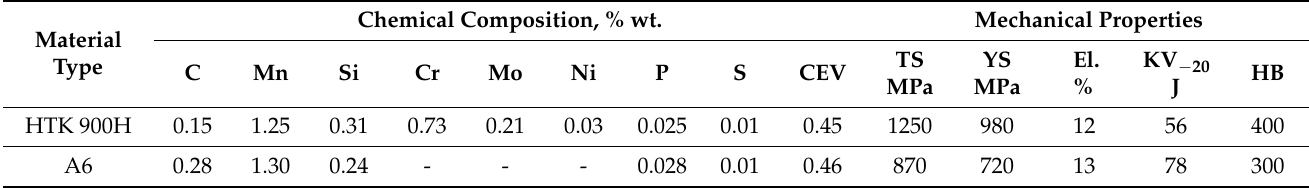
Table 1. Characteristics of HTK 900H and A6 base materials based on the certificates [19,20]. Chemical Composition, % wt. Material Type